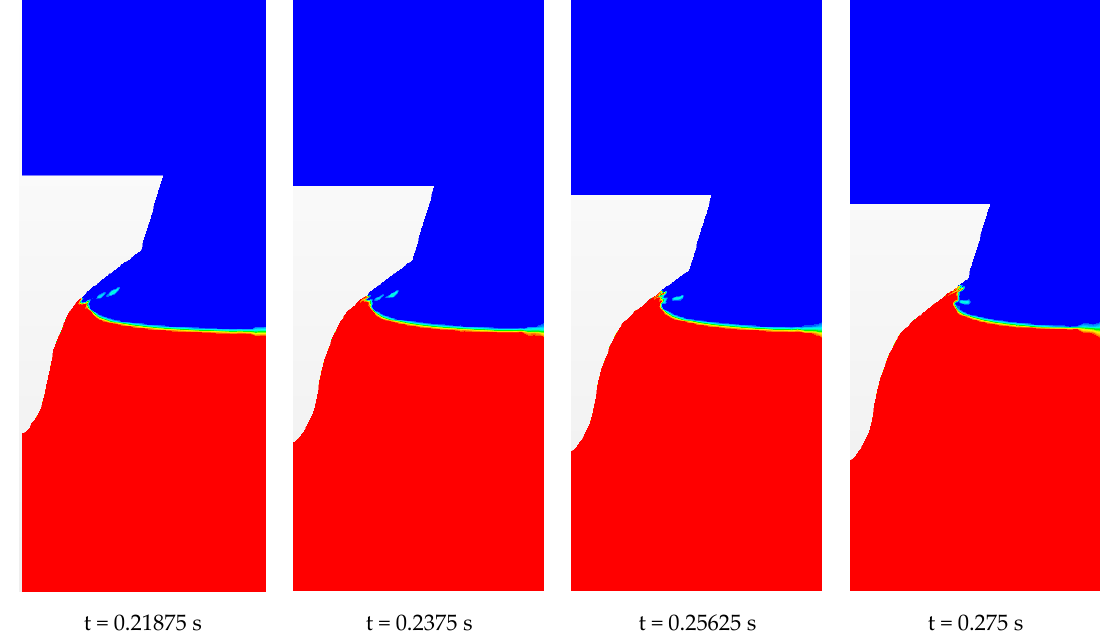
Figure 14. Free surface evolution during the water entry of the modified section “S3”.